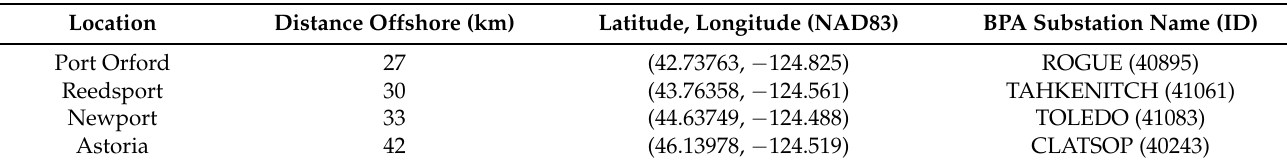
Table 1. OSW resource locations and interconnections to 230 kV BPA transmission substations. Location Distance Offshore